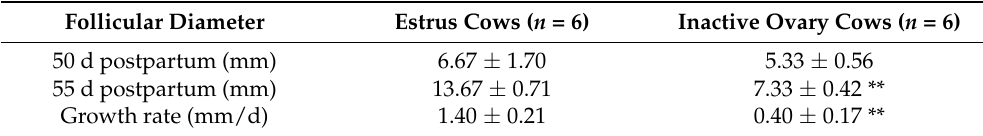
Table 2. Follicular development at 50 to 55 d postpartum.